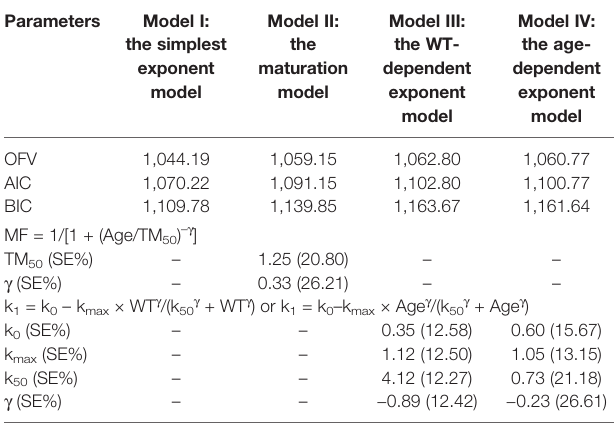
TABLE 2 | Parameter estimates of the four physical maturation clearance candidate